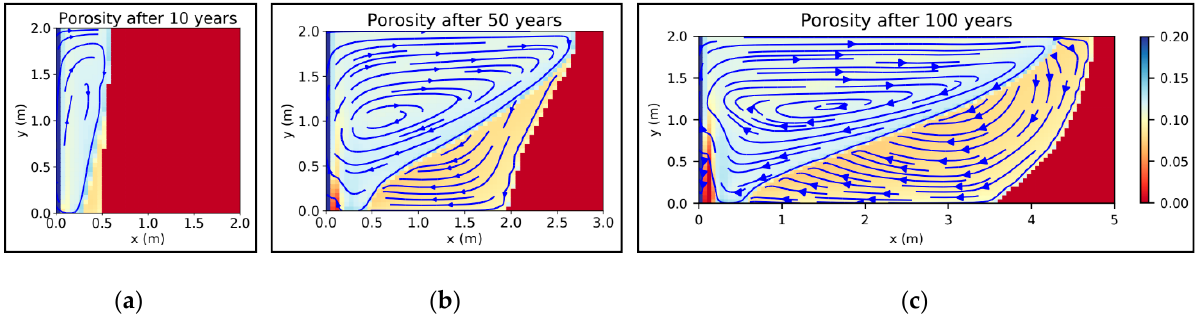
Figure 13. Porosity distribution within an ( a ) initially reaction- and diffusion-dominated system; ( b , c ) in the long run transport-dominated and with an increasing influence of advection (scenario: dissolution rate 10 − 6 cm/s and 10 wt.% car- nallite).